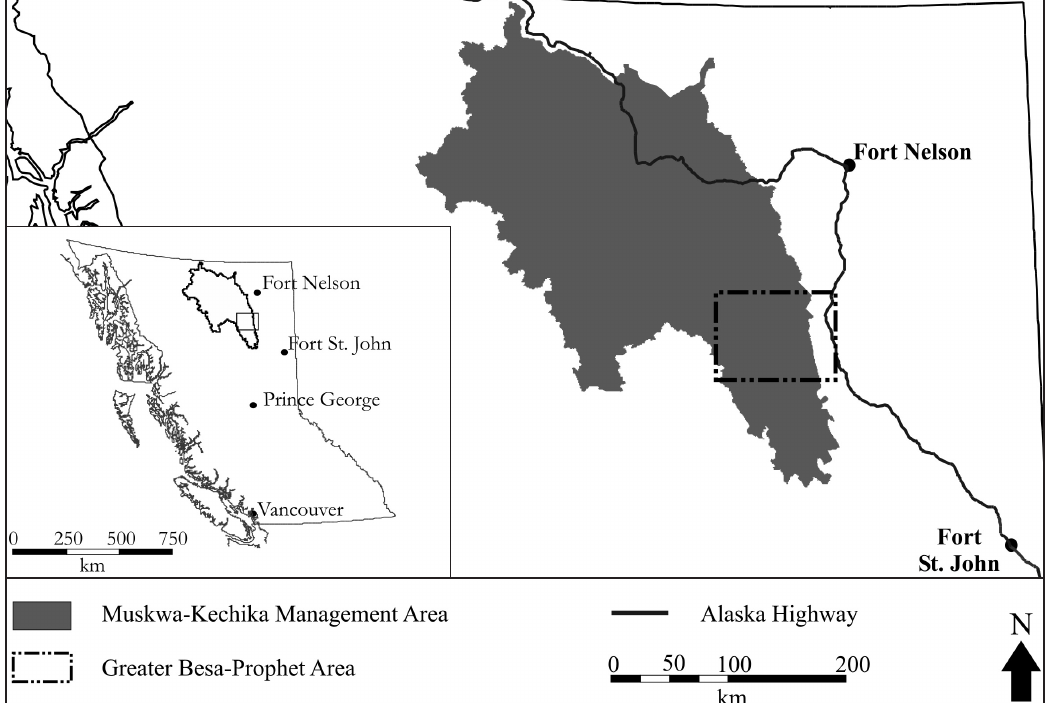
Fig. 1. The Greater Besa-Prophet Area of the Muskwa-Kechika Management Area in northern British Columbia, Canada.